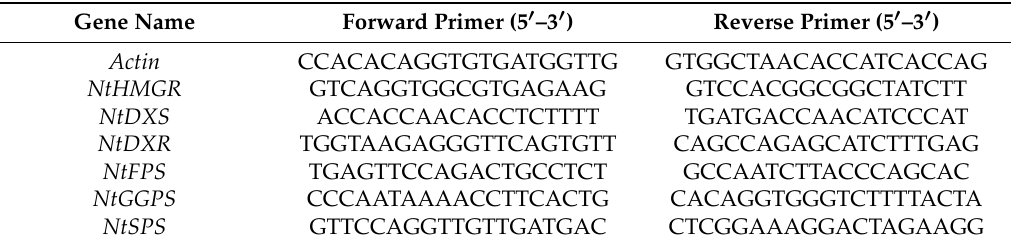
Table 1. Primers used for quantitative real-time PCR (qRT-PCR) in the present study